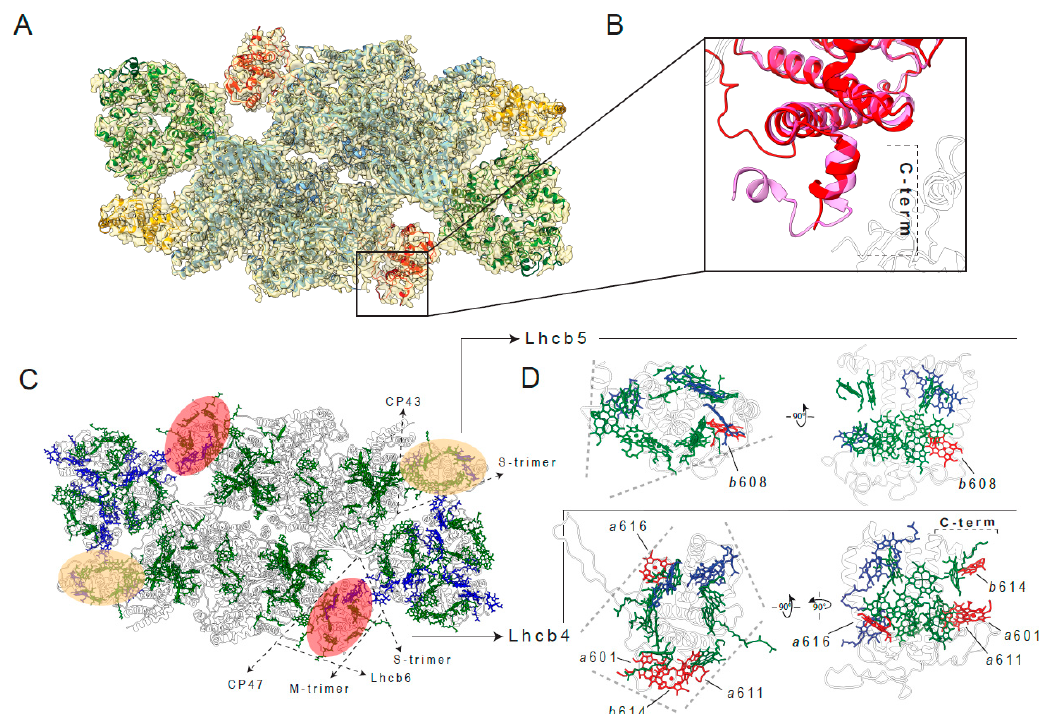
Figure 3. Peculiar features of proteins and chlorophylls of the C 2 S 2 supercomplex isolated from plants grown in high-light. ( A ) Cryo-EM density map of the C 2 S 2 -H at 3.8 Å viewed from the lumenal side, normal to the membrane plane, and assigned subunits of the PSII dimer in cyan, LHCII-S trimer in green, Lhcb4 in red and Lhcb5 in orange. ( B ) Structural superposition of the C-terminal region of Lhcb4 (red) and Lhcb4 from PDB: 5XNL (chain R, purple) [22]. ( C ) Overview of all chlorophylls a (green) and b (blue) in the supercomplex shown from the lumenal side. ( D ) Representation of Lhcb4 and Lhcb5 with chlorophyll a (green) and chlorophyll b (blue) molecules. In panel ( D ), chlorophylls present in the pea C 2 S 2 supercomplex from PDB: 5XNL (chain R for Lhcb4 and chain S for Lhcb5) [22] and missing in the C 2 S 2 -H are highlighted in red, the top view (on the left) and side view (on the right) of proteins are along the membrane plane.